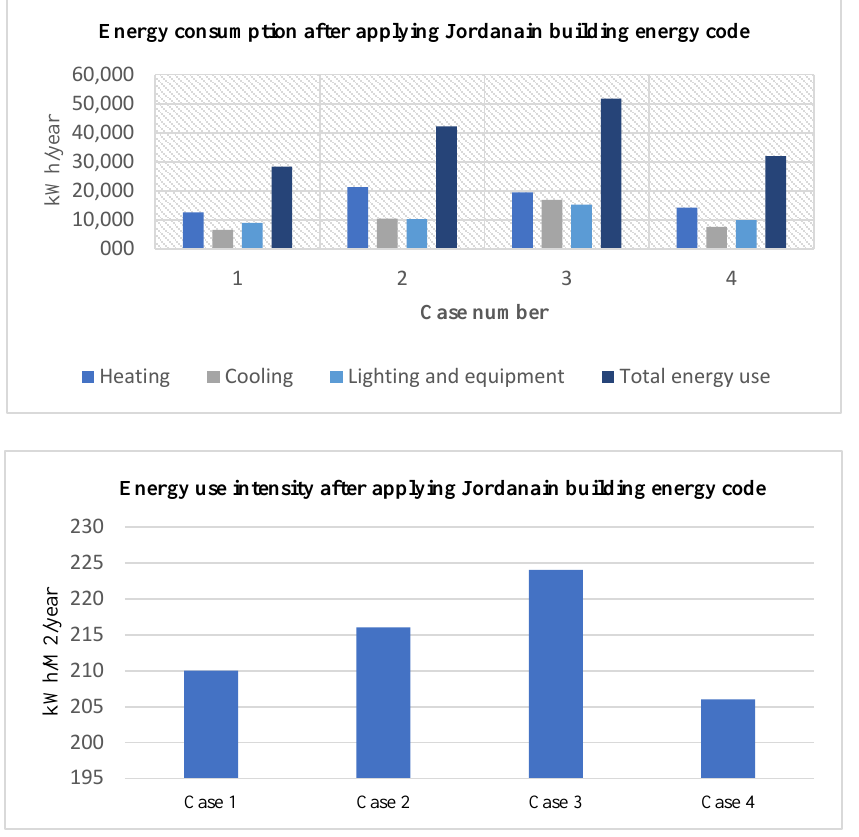
Figure 7. Energy end-use and energy-use intensity after applying Jordan’s building energy code.